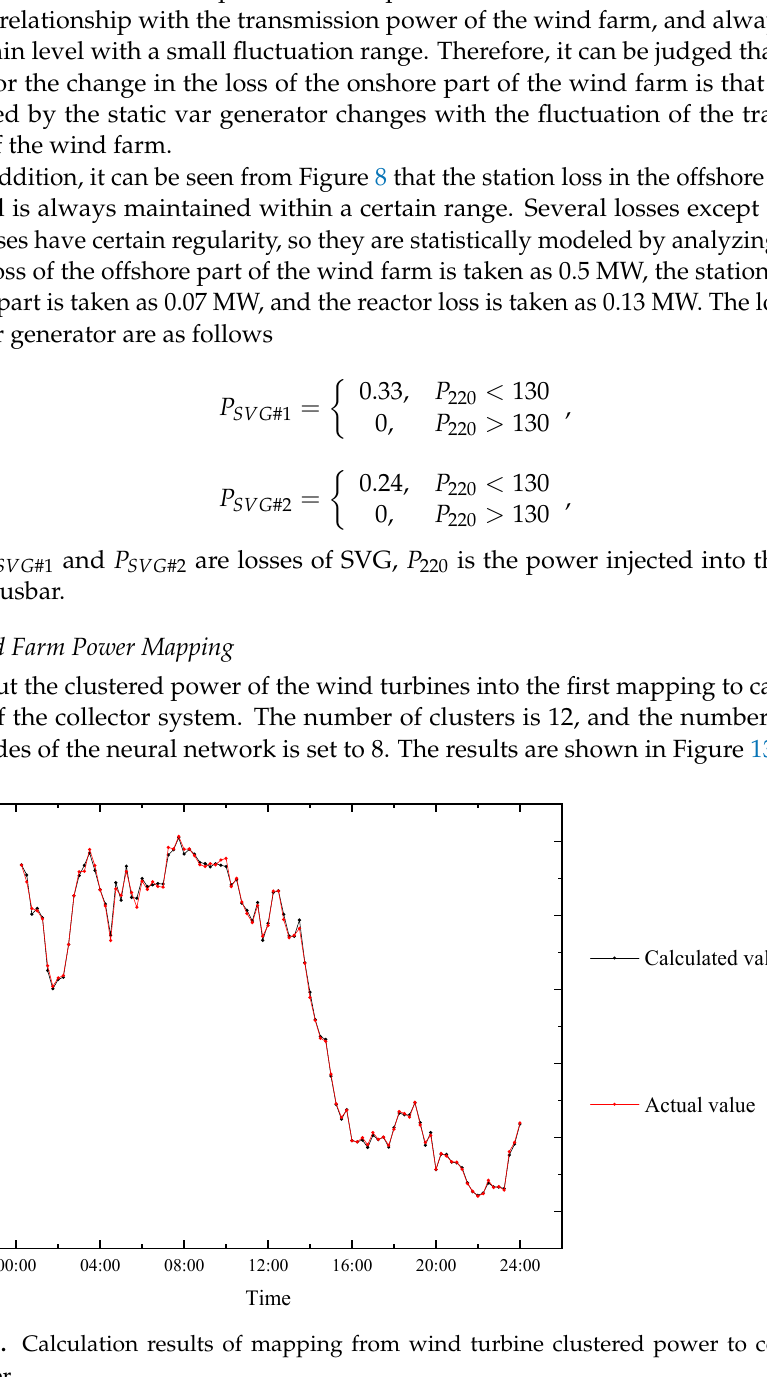
Table 2. Comparison of errors in the power calculation results of the collector system.